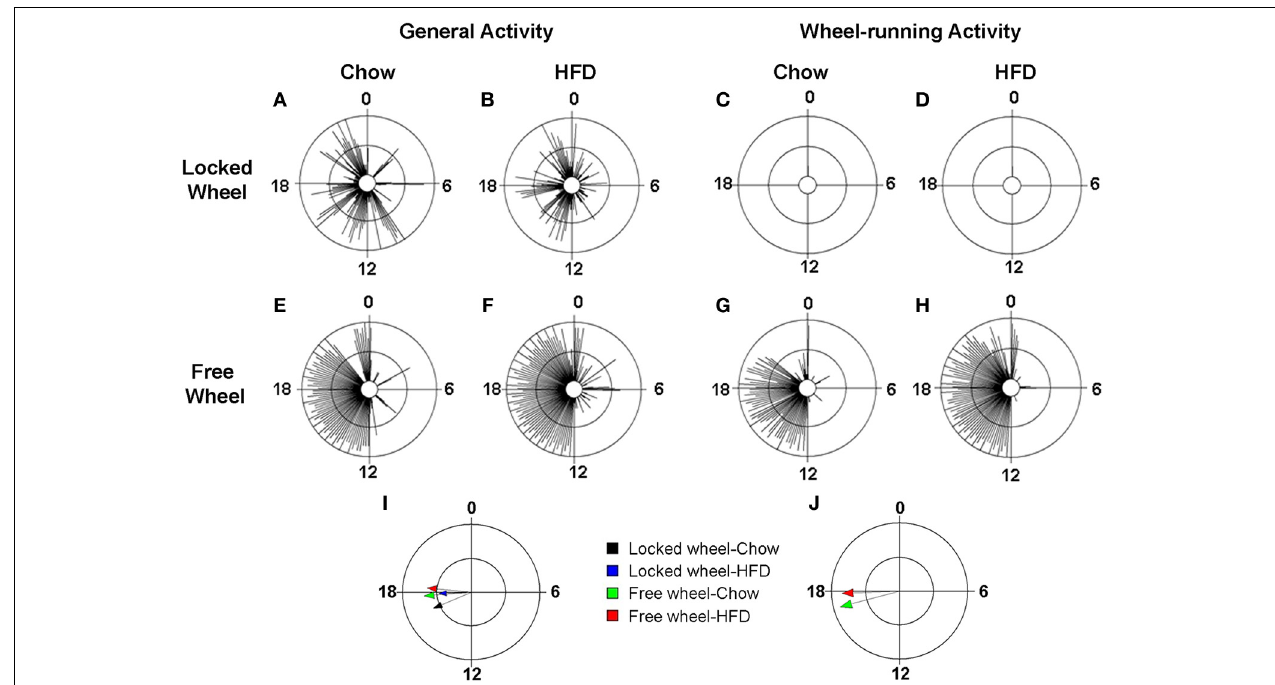
FIGURE 4 | Locomotor activity rhythms in chow and high-fat diet-fed mice. Male wild-type mice were single-housed in 12L: 12D with locked (A–D) or freely rotating (E–H) running wheels at 7 weeks old. Chow was provided ad libitum for 1 week (Days 1–7) and then chow was replaced with high-fat diet (HFD) for 1 week (Days 8–15). Representative circular histograms ( A–H ; plotted in 10-min bins; scale: inner circle, 0; middle circle, 5.5, outer circle, 11; units: activity counts per 10-min bin) show the distribution of general activity ( A,B,E,F ; measured with a passive infrared sensor) and wheel activity ( G,H ; no wheel revs in C,D because wheel was locked) for a mouse during chow